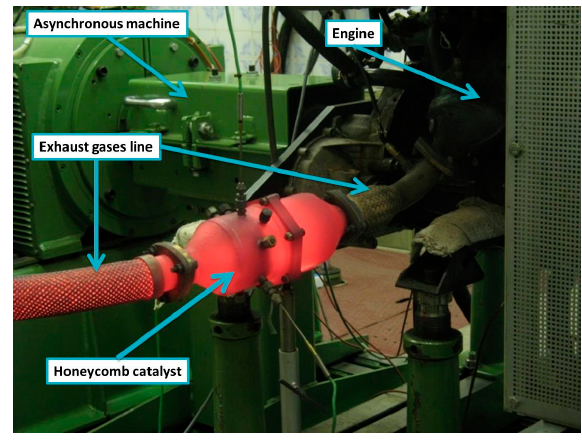
Figure 6. Photograph of the engine bench unit.